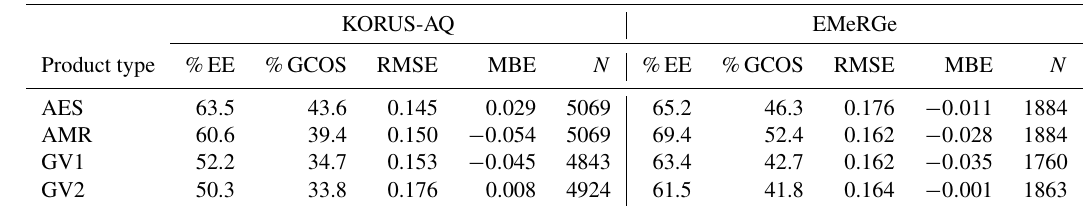
Table 2. Validation statistics of the respective satellite product during the KORUS-AQ and the EMeRGe campaign.